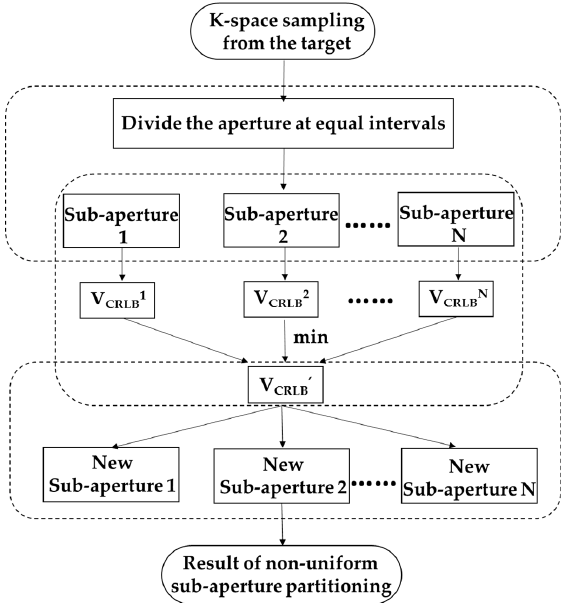
Figure 3. The flowchart of the non-uniform sub-aperture partitioning method.